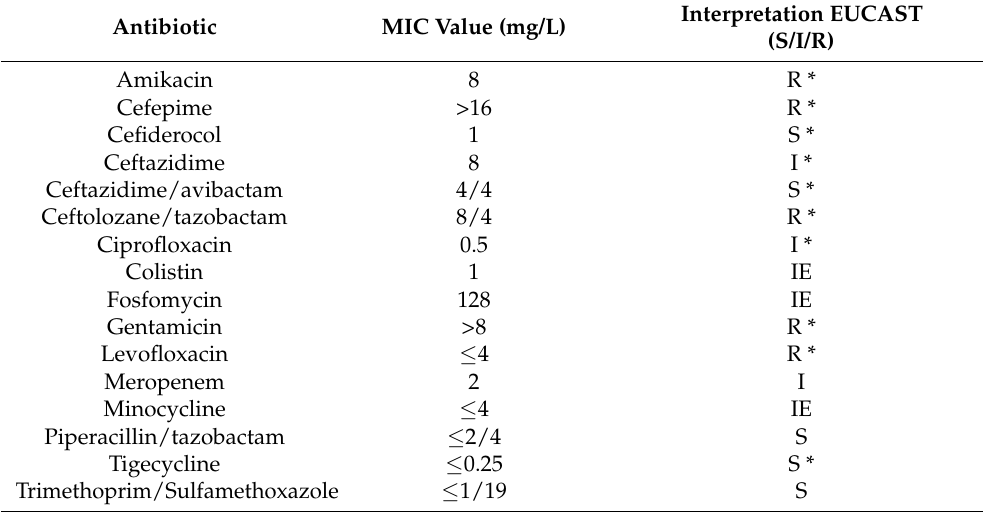
Table 1. Antimicrobial susceptibility testing results for the isolate included in the study. Antibiotic MIC Value (mg/L)